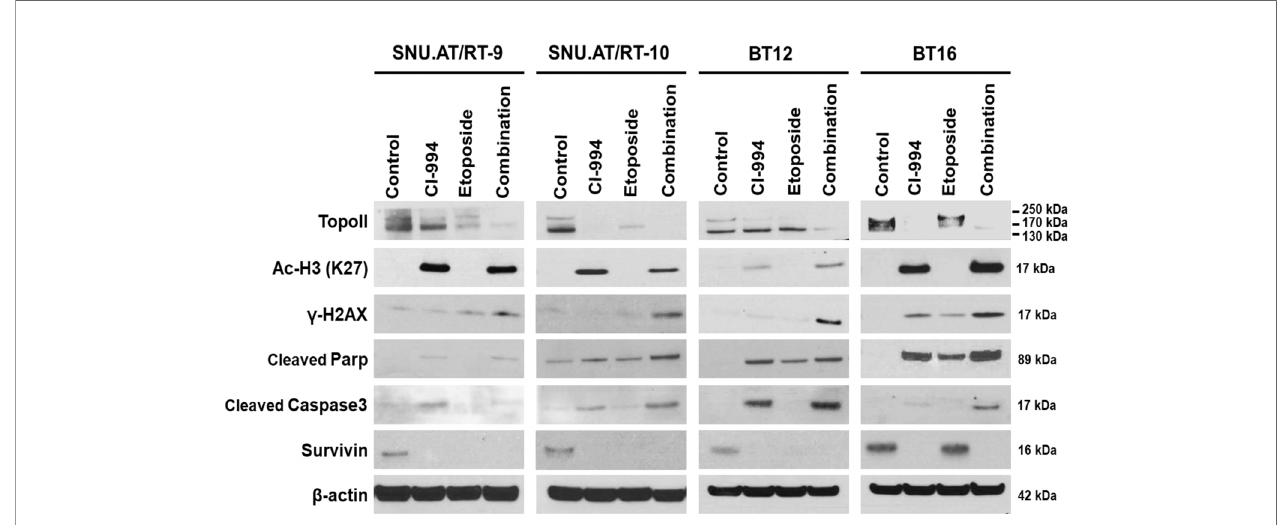
FIGURE 7 | Protein expression involved in the synergistic effect of the combination treatment of CI-994 with etoposide. Western blot analysis shows the levels of topoisomerase (Topo) II, histone 3 acetylation (Ac-H3), g -H2AX, cleaved Parp, cleaved Caspase-3 and Survivin in response to the combination treatment of CI-994 with